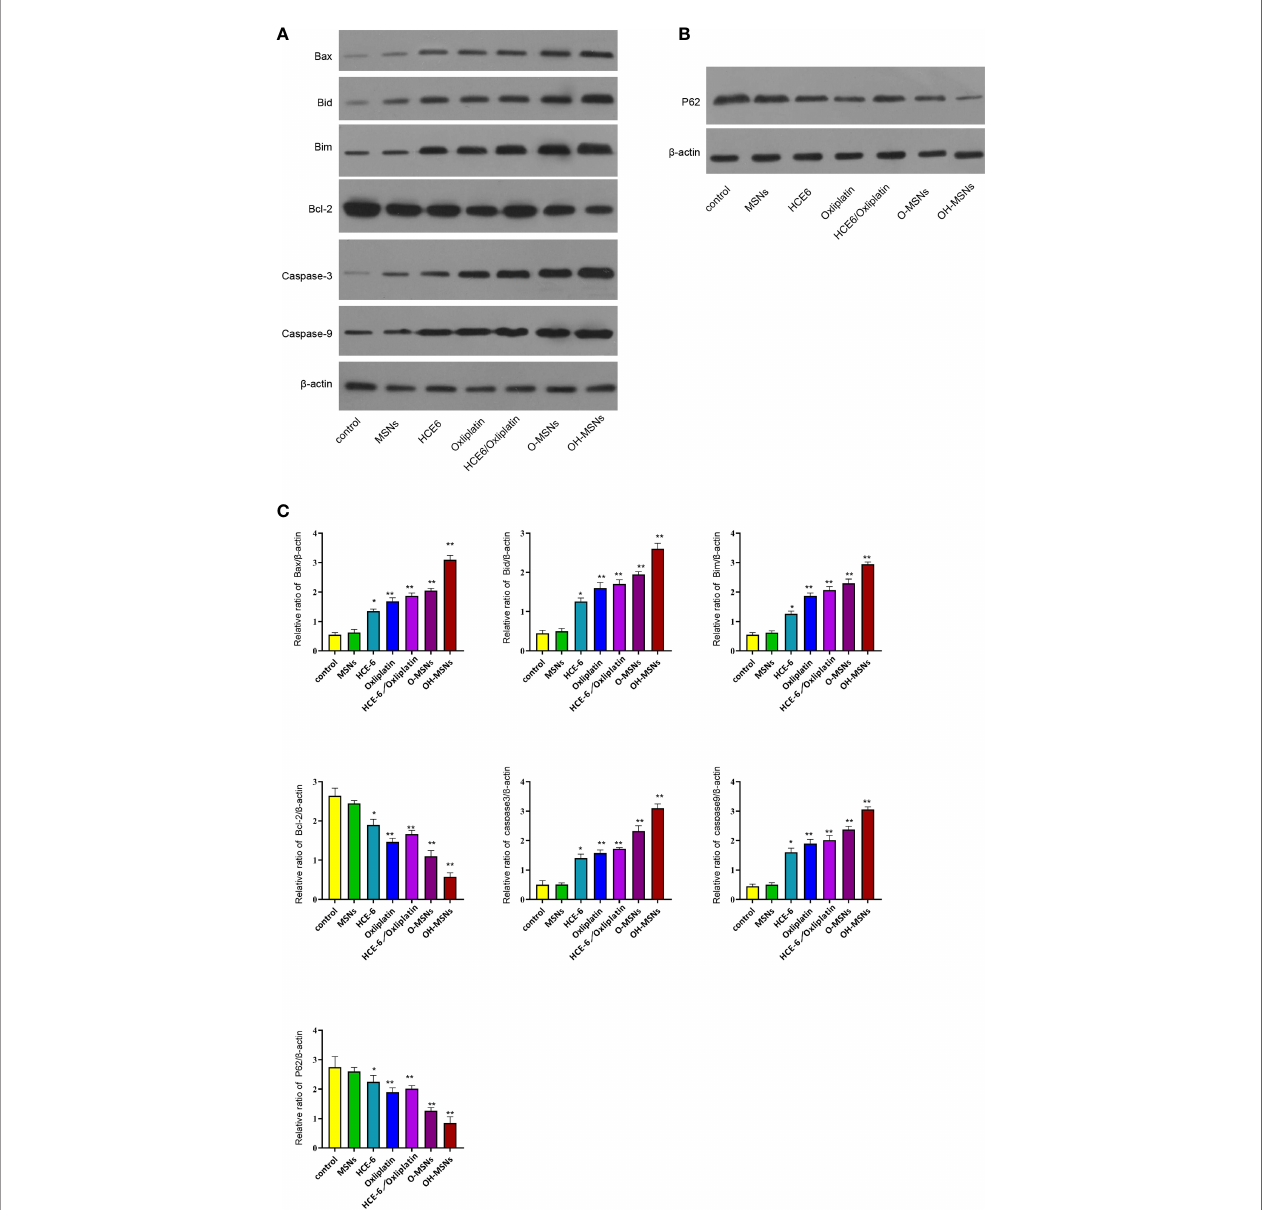
FIGURE 6 | Expression levels of autophagy and apoptosis-related proteins in bile duct cancer cells. (A – C) The FRH0201 cells were treated as the indicated labeling. (A) The expression of Bax, Bid, Bim, Bcl-2, caspase3, caspase9 was measured by Western blot analysis. (B) The expression of P62 was detected by Western blot analysis. (C) The quanti fi cation of the Western blot analysis in A and B was analyzed by ImageJ software. Data are presented as mean ± SD. Statistic signi fi cant differences were indicated: *P < 0.05, **P <